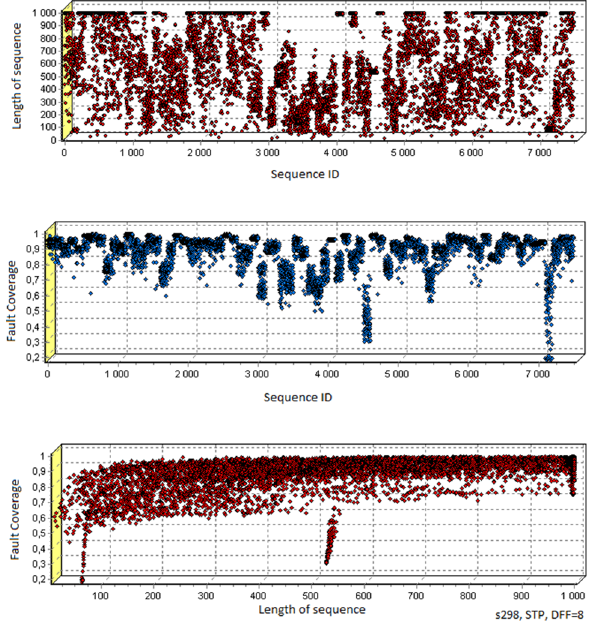
Fig. 31 STP for s298 with use of 10 internal flip-flops